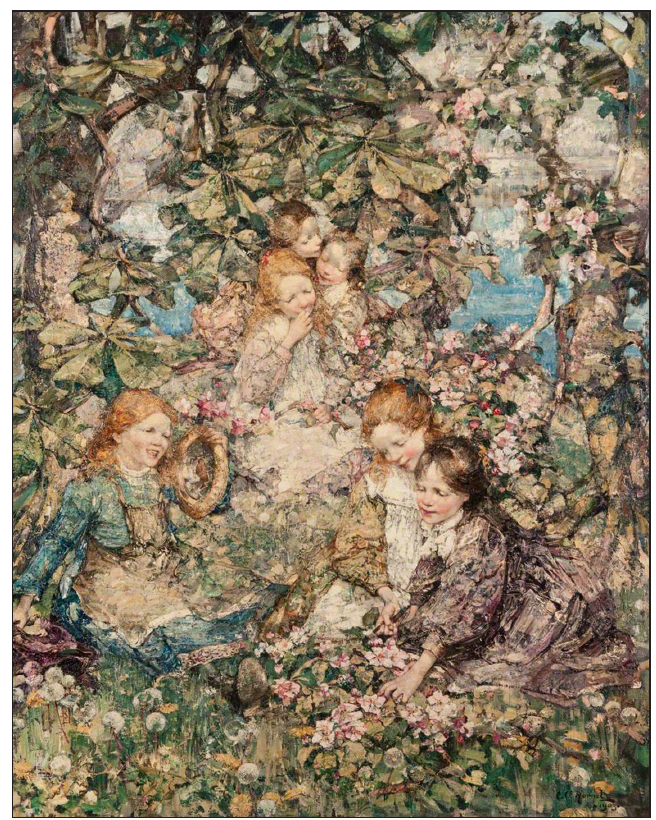
Fig. 2 : Edward Atkinson Hornel, Spring , 1903, oil on canvas, 152 × 122.5 cm, McLean Museum and Art Gallery. Gift from the Trustees of the Stuart Anderson Caird Bequest 1930,